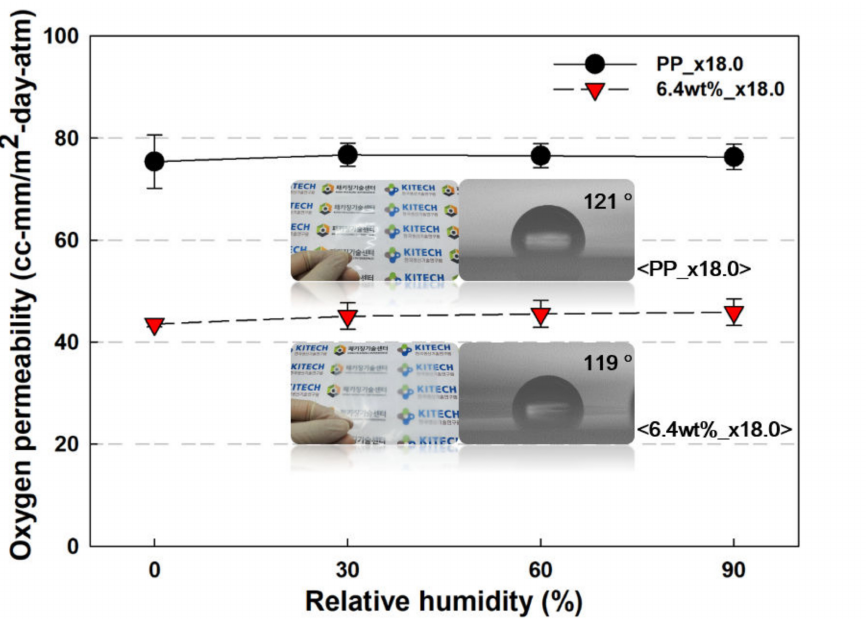
Figure 9. Oxygen permeability results of PP and PP/nanclay nanocomposite according to the increase in RH % (visual comparison of the samples and contact angle results are included in the